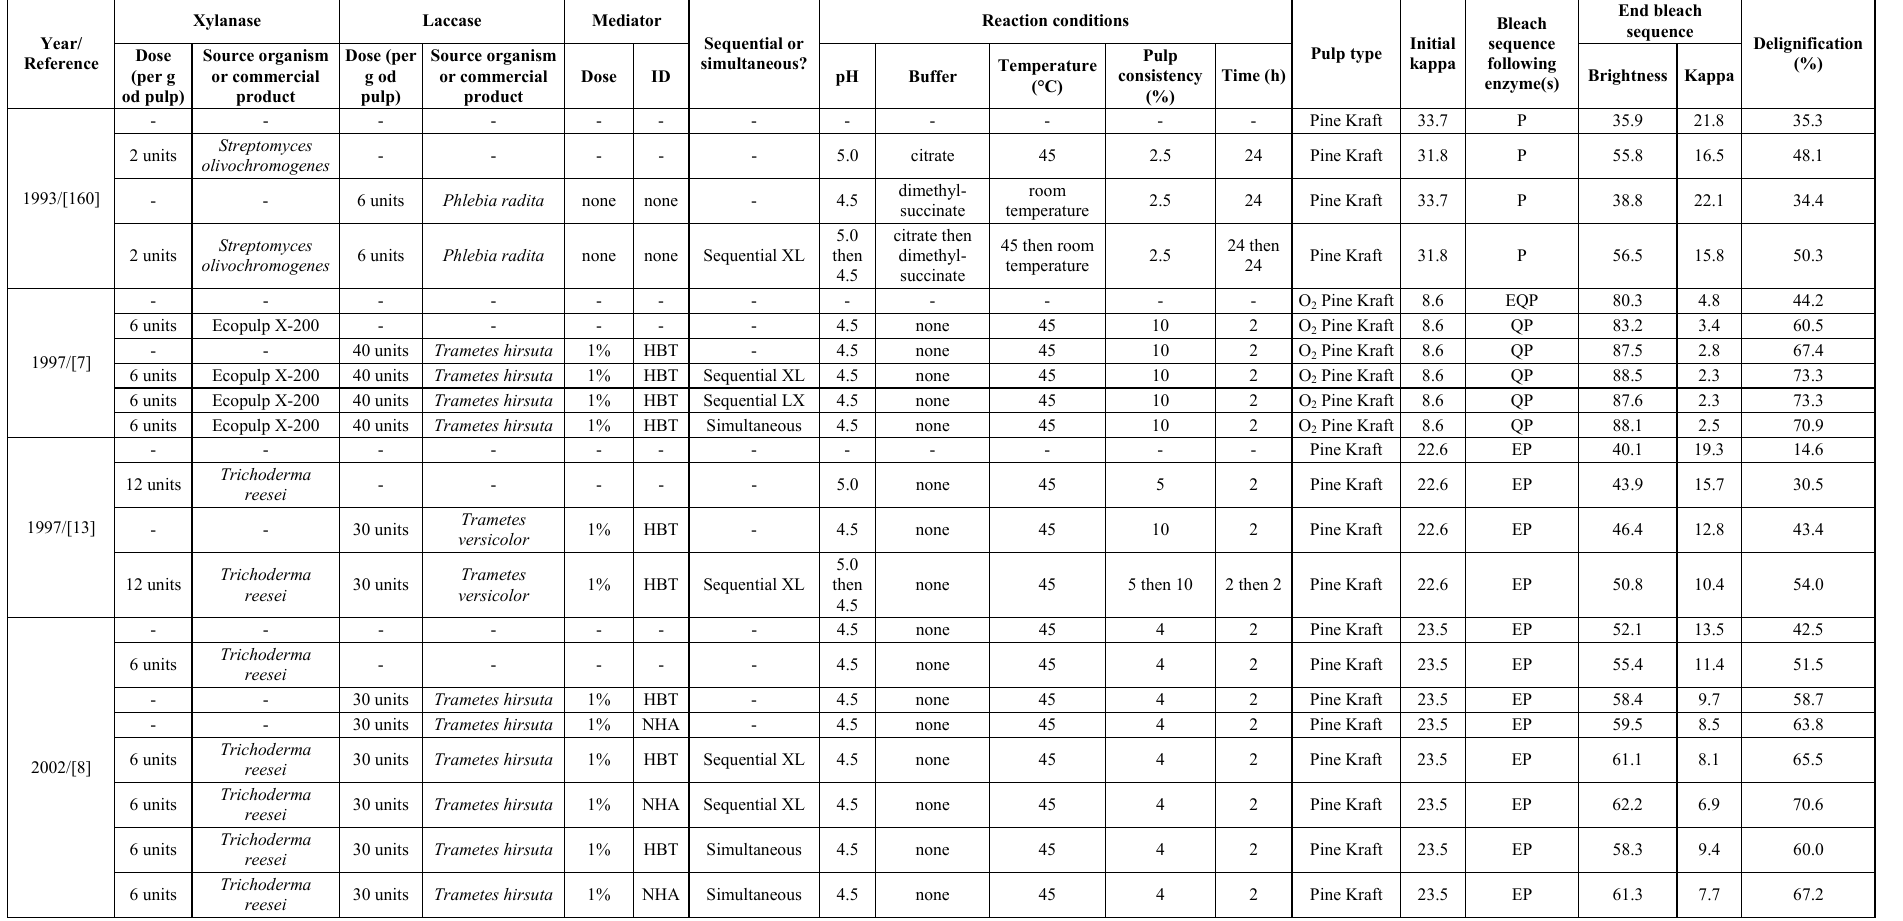
Table 3. Delignification of Pulp by Mixed Enzyme